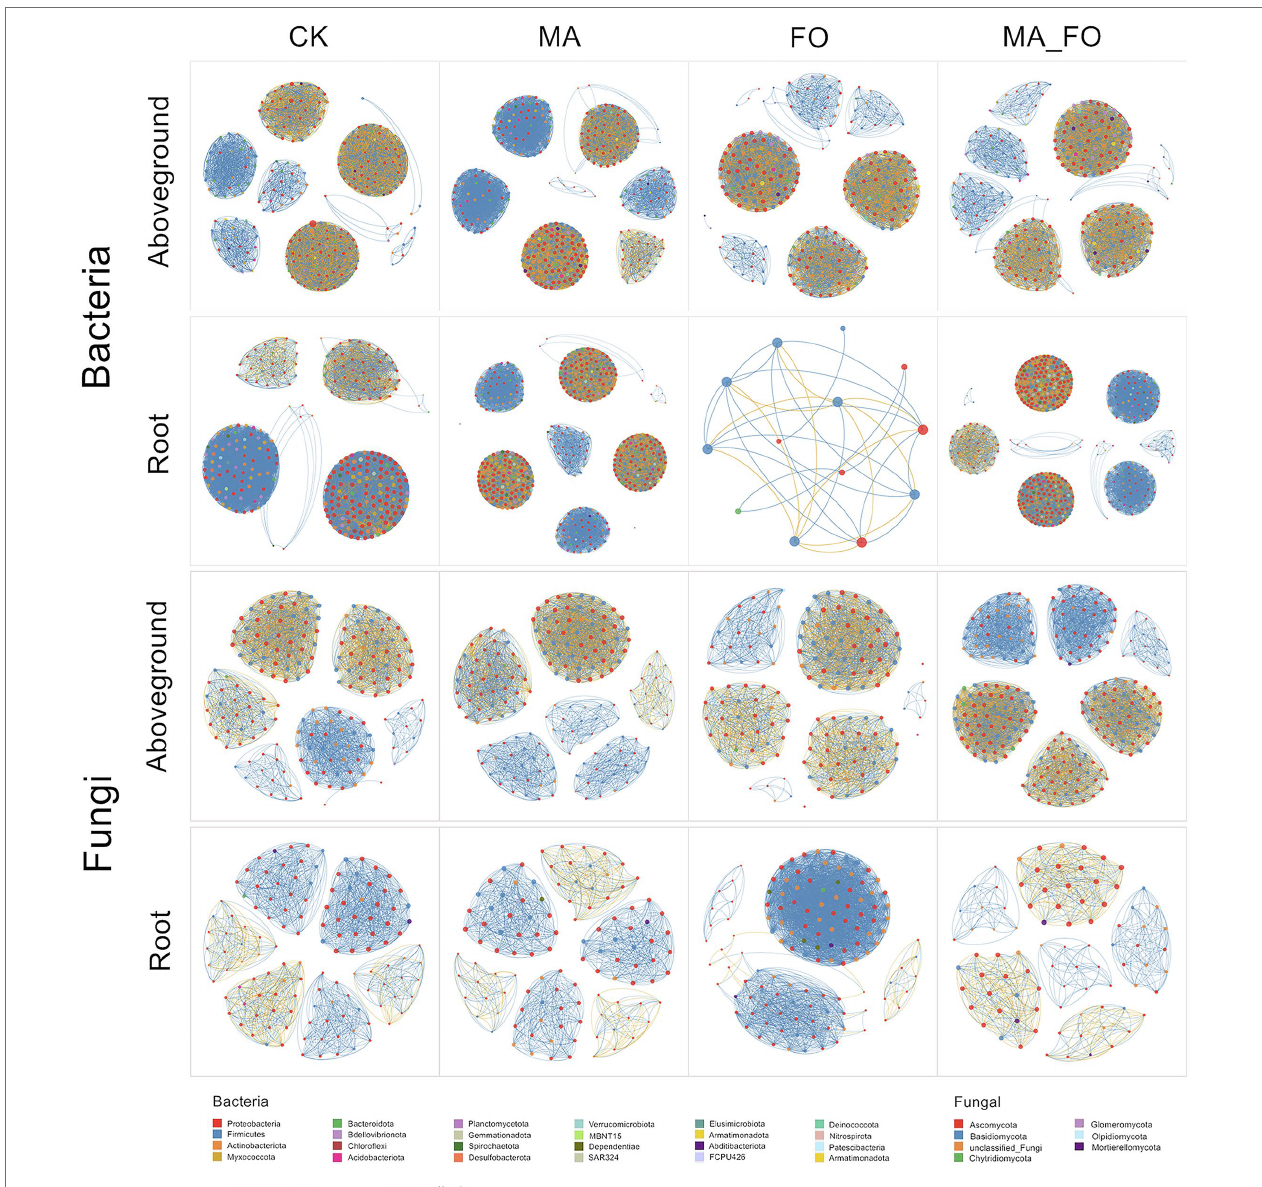
FIGURE 6 | Analysis of microbial co-occurrence network in ginseng under different inoculation treatments. The nodes are colored according to bacterial and fungal phylum. Node size indicates the relative abundance of OTU. Edge color represents positive (blue) and negative (orange) correlations.